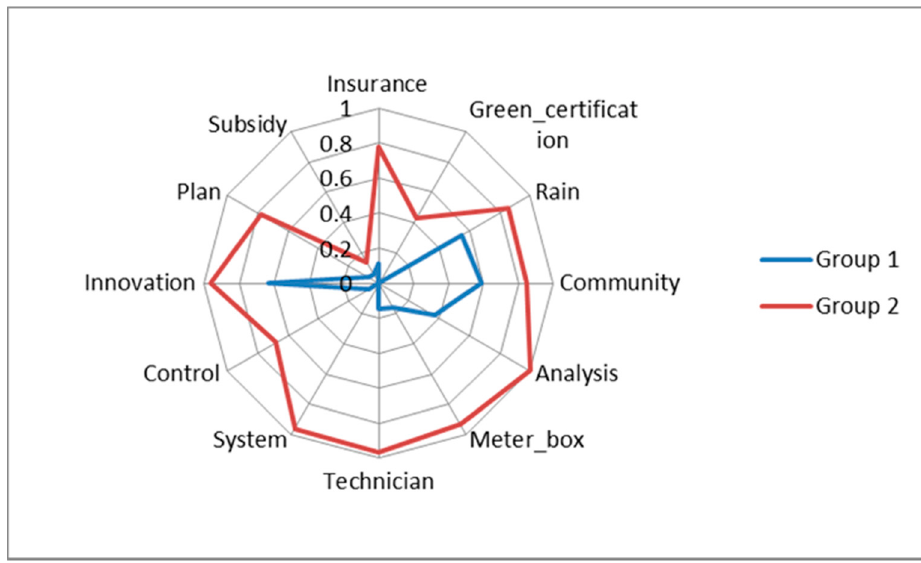
Figure 5. Average scores for Groups 1 and 2 on dummy variables.